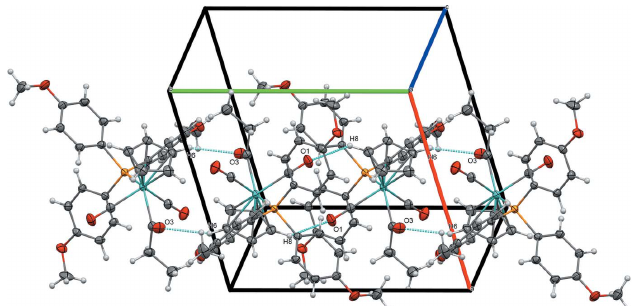
Figure 8 Chains of ( 3 ) along [010], viewed perpendicular to